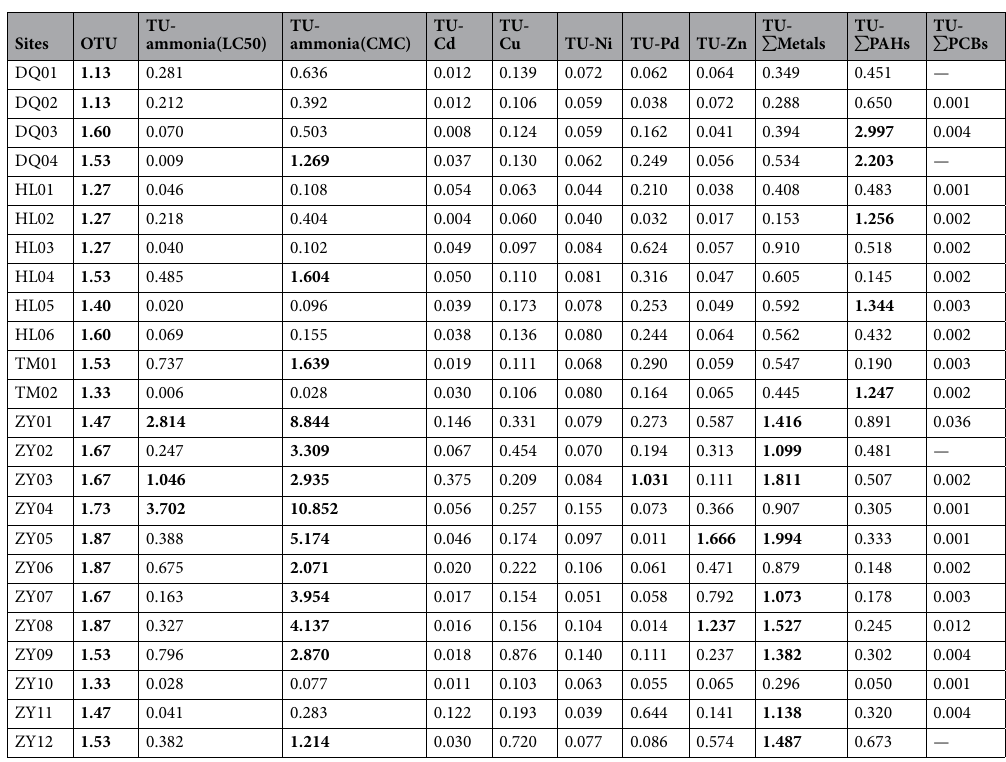
Table 1. Sum of the Observed Toxic Units (OTU) and the Predicted Toxic Units (PTU) for ammonia, heavy metals (Cd, Cu, Ni, Pb, and Zn), total PAHs, and